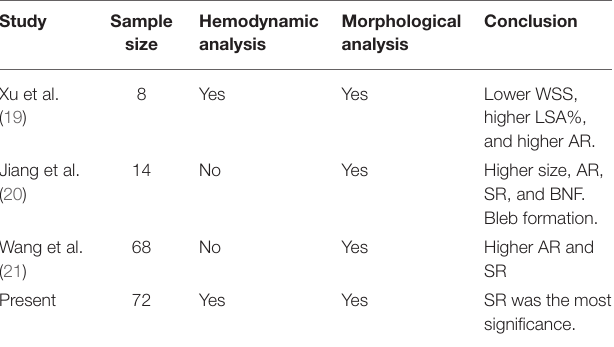
TABLE 5 | Previous studies on hemodynamic or morphological analysis of mirror PComAAs.